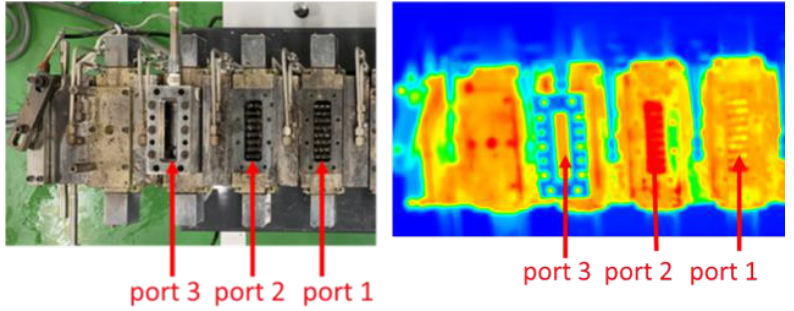
Figure 7. Thermal image of temperature distribution in the octa-screw extruder.